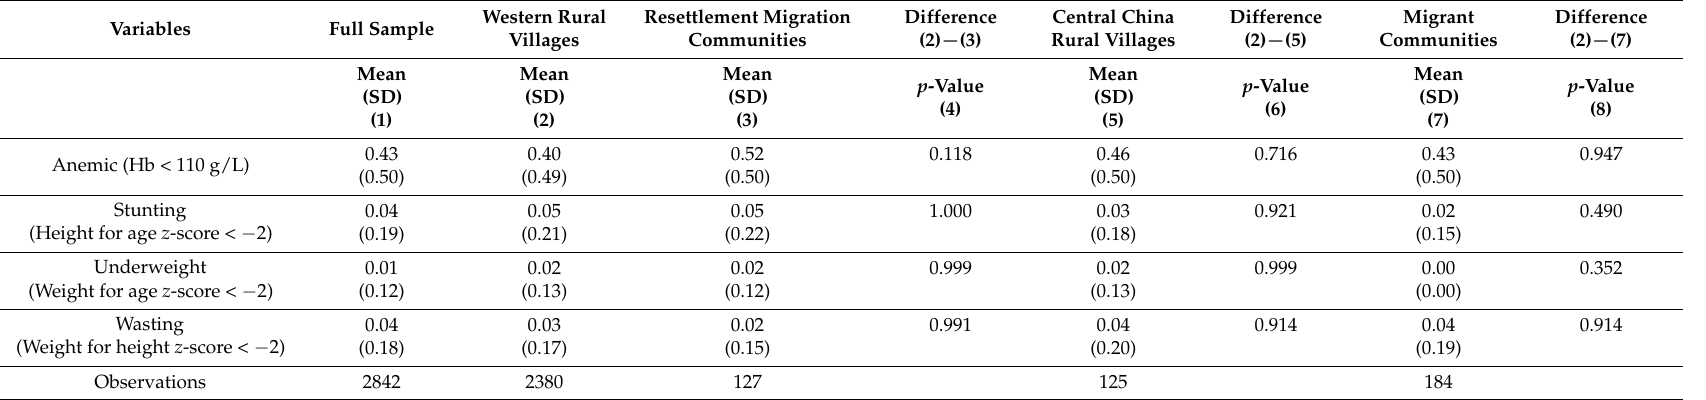
Table 3. Health outcomes of